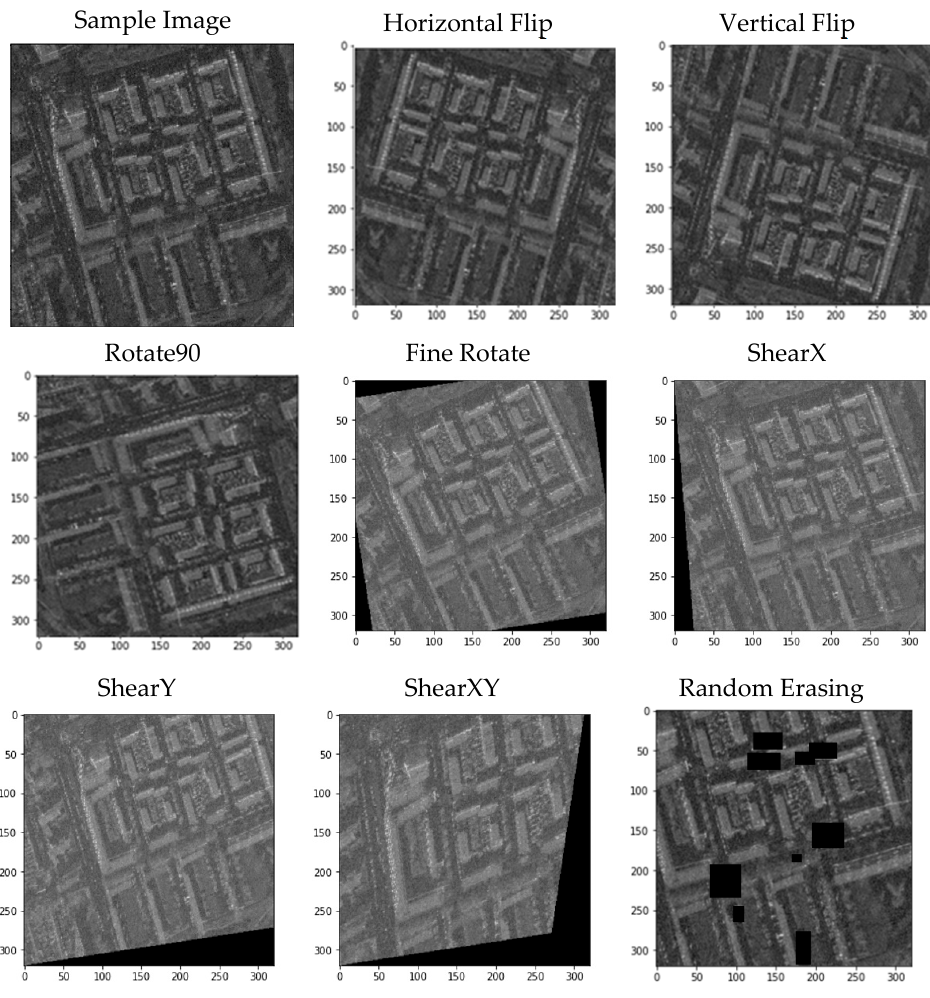
Figure 9. Summary of Geometric